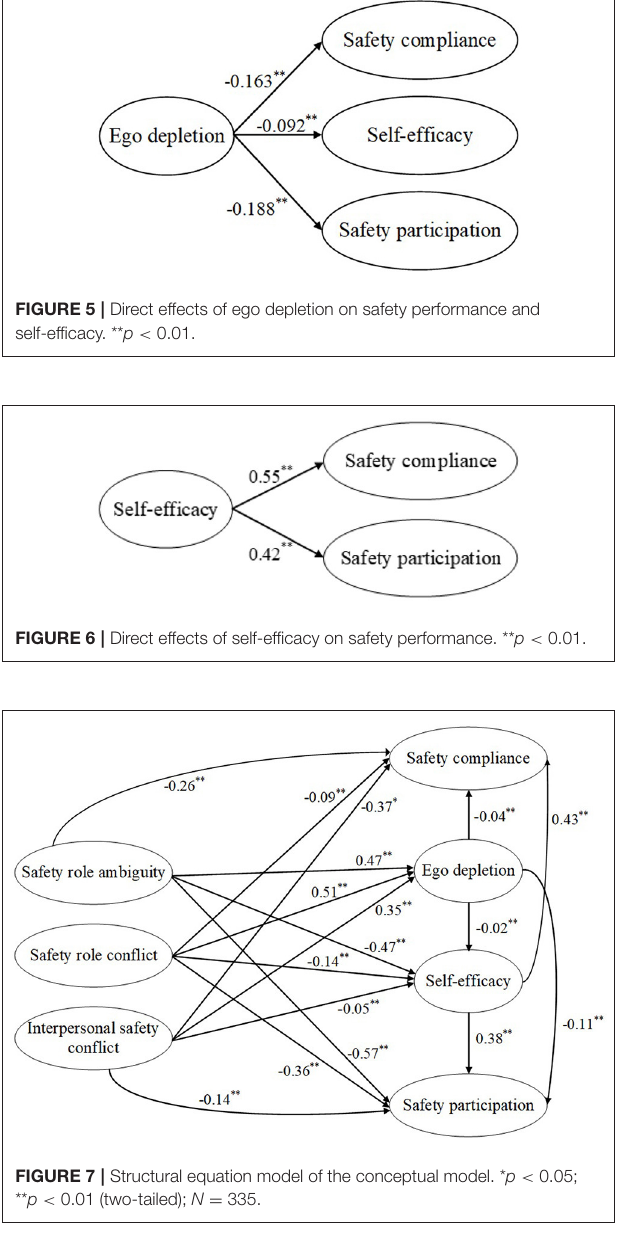
= 0.033, SRMR = 0.045) indicated that the overall